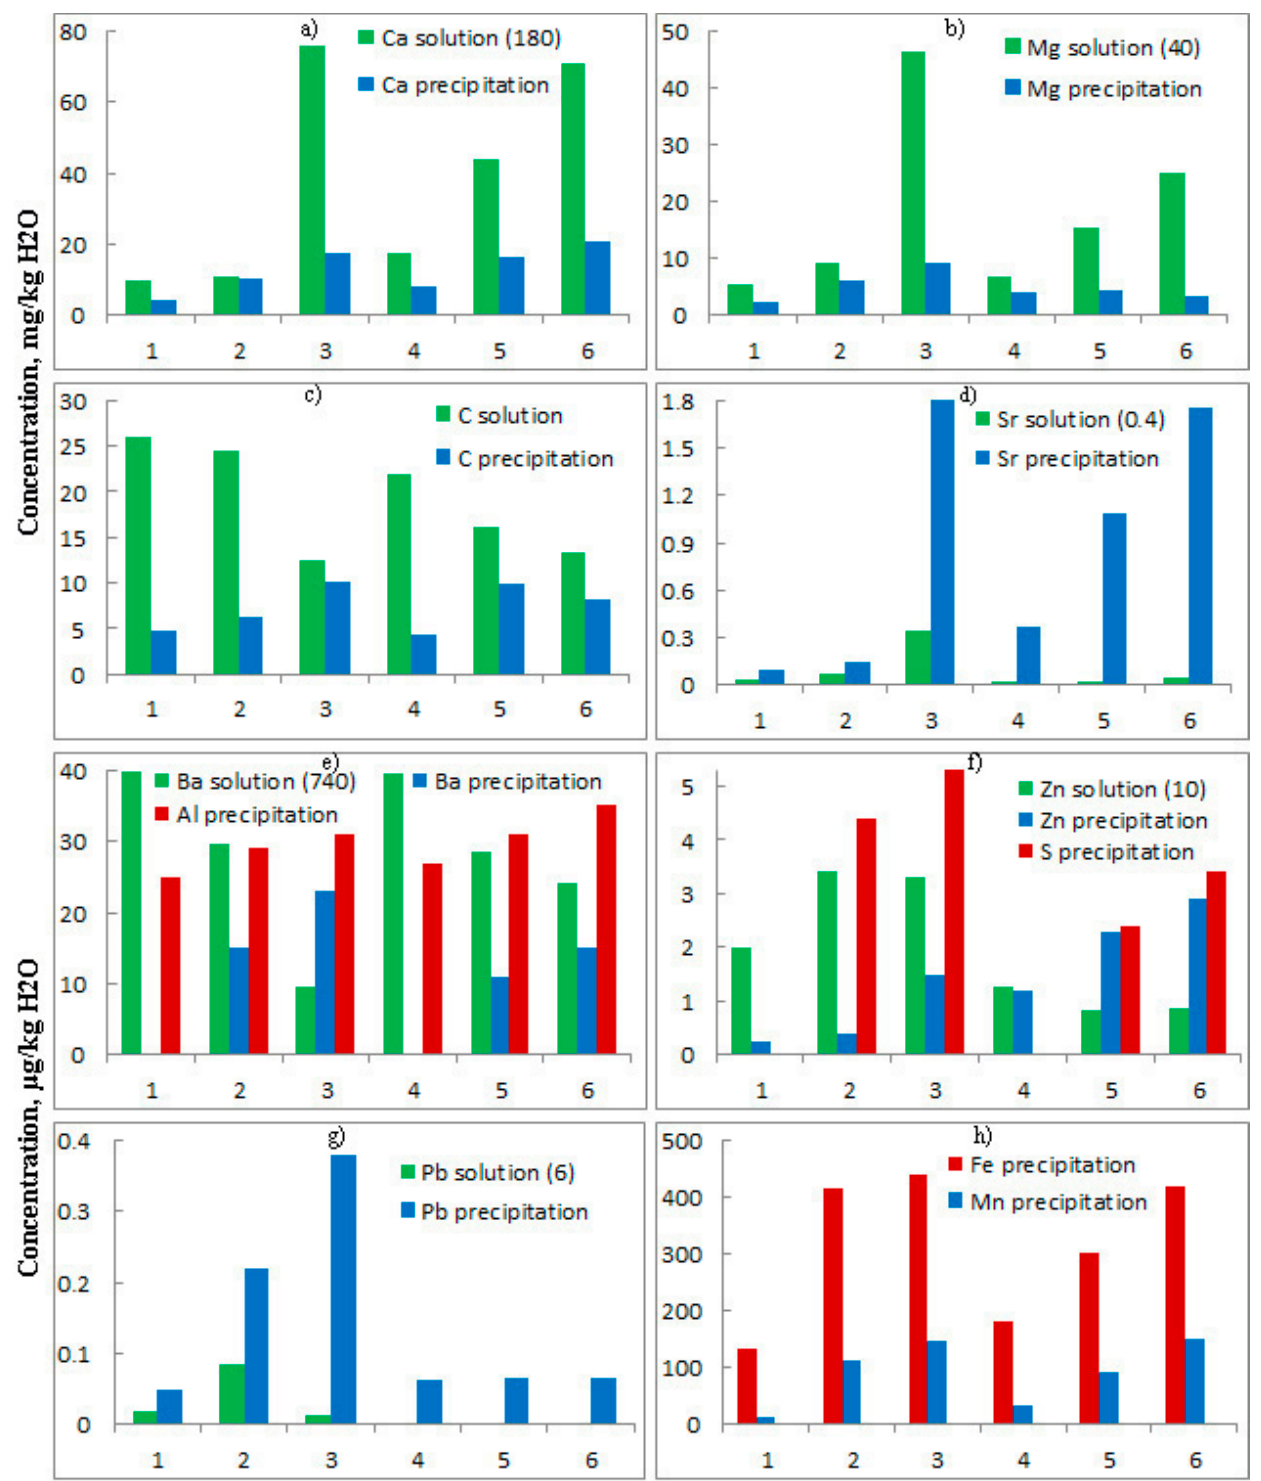
Figure 4. Concentrations of major and trace elements in solution and precipitate: ( a ) Ca; ( b ) Mg; ( c ) C; ( d ) Sr; ( e ) Ba and Al; ( f ) Zn and S; ( g ) Pb; ( h ) Fe and Mn, calculated as a result of modeling mixing of surface and groundwater according to Scenarios 1–6 (see Tables 2 and 3).